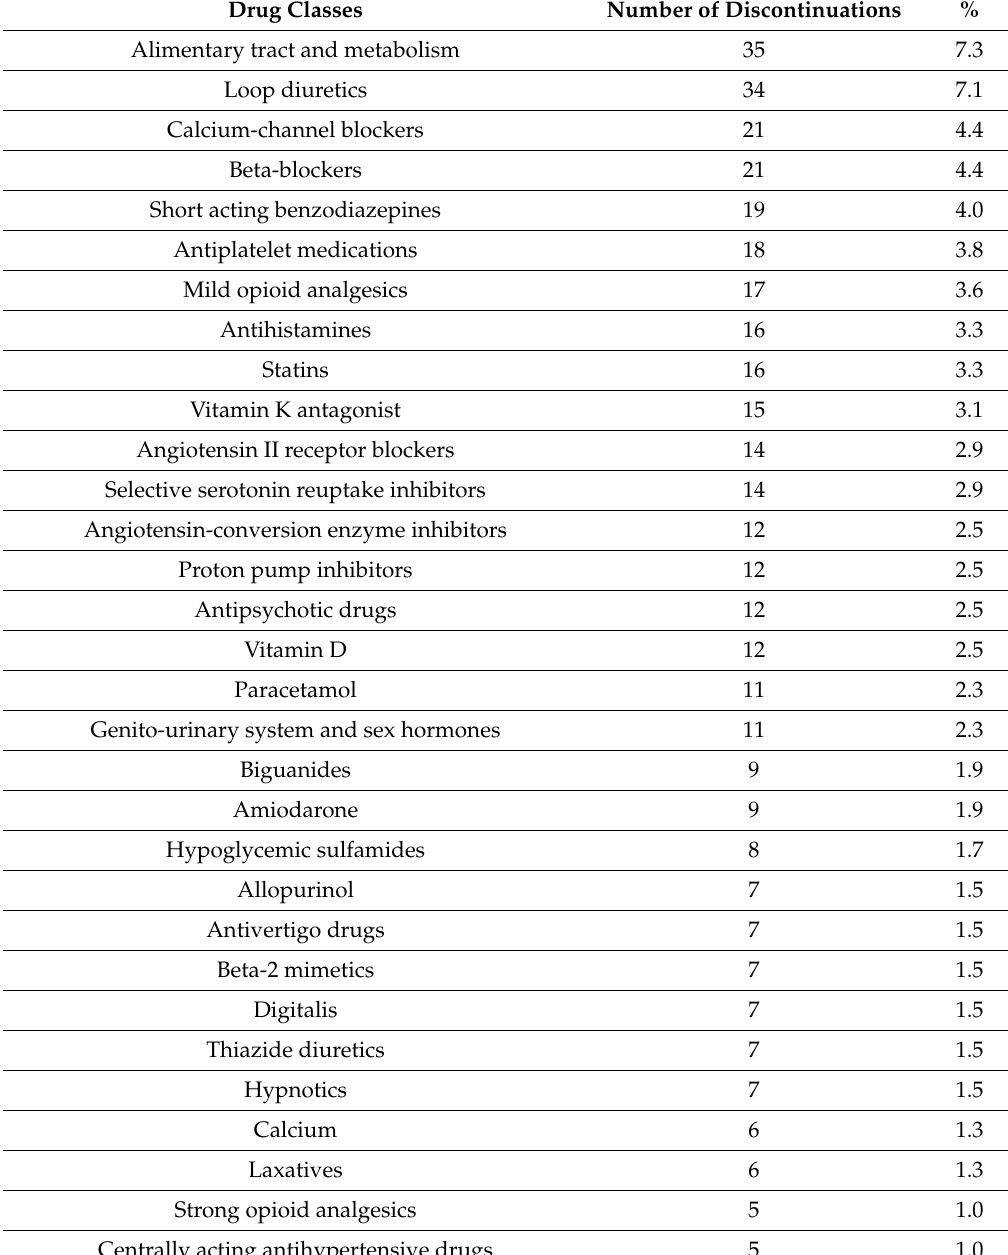
Table 2. Drug discontinuations during the